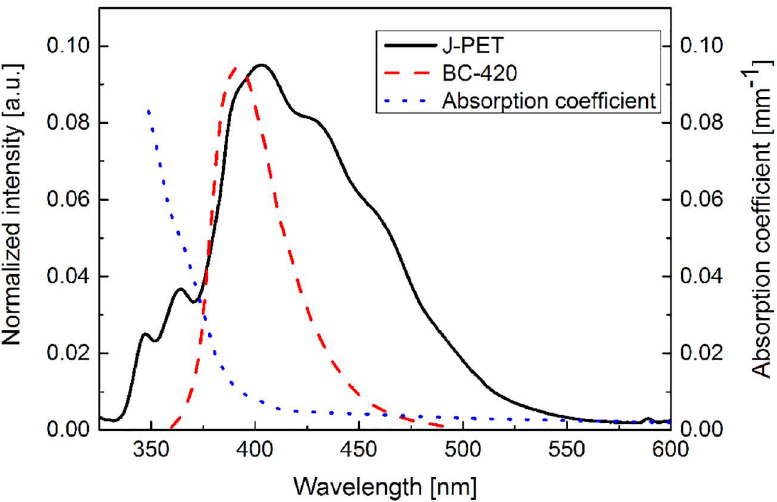
Fig 6. Emission spectraof BC-420, J-PET scintillator and scintillators’ absorption coefficient μ eff [37, 38]. The emissionspectra are normalized in amplitude.